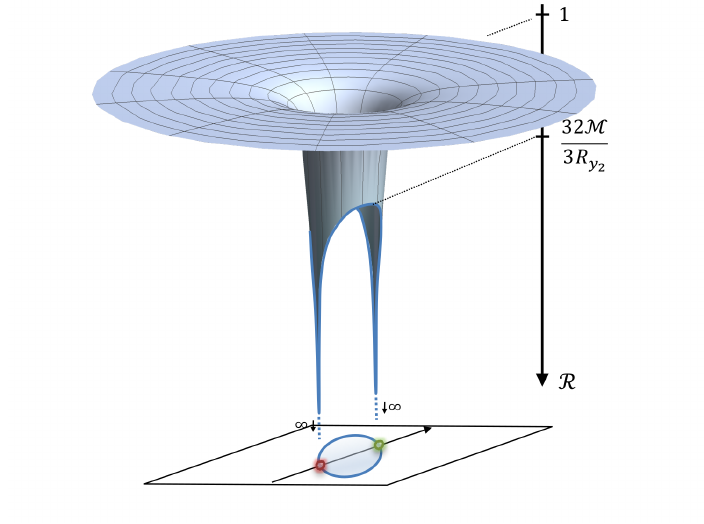
Figure 9 . Redshift factor of the neutral bound states of two extremal black holes at the poles a vacuum bubble as a function of ( r, θ ) (3.31). The surface of the bubble is at r = ‘ ∼ 4 M